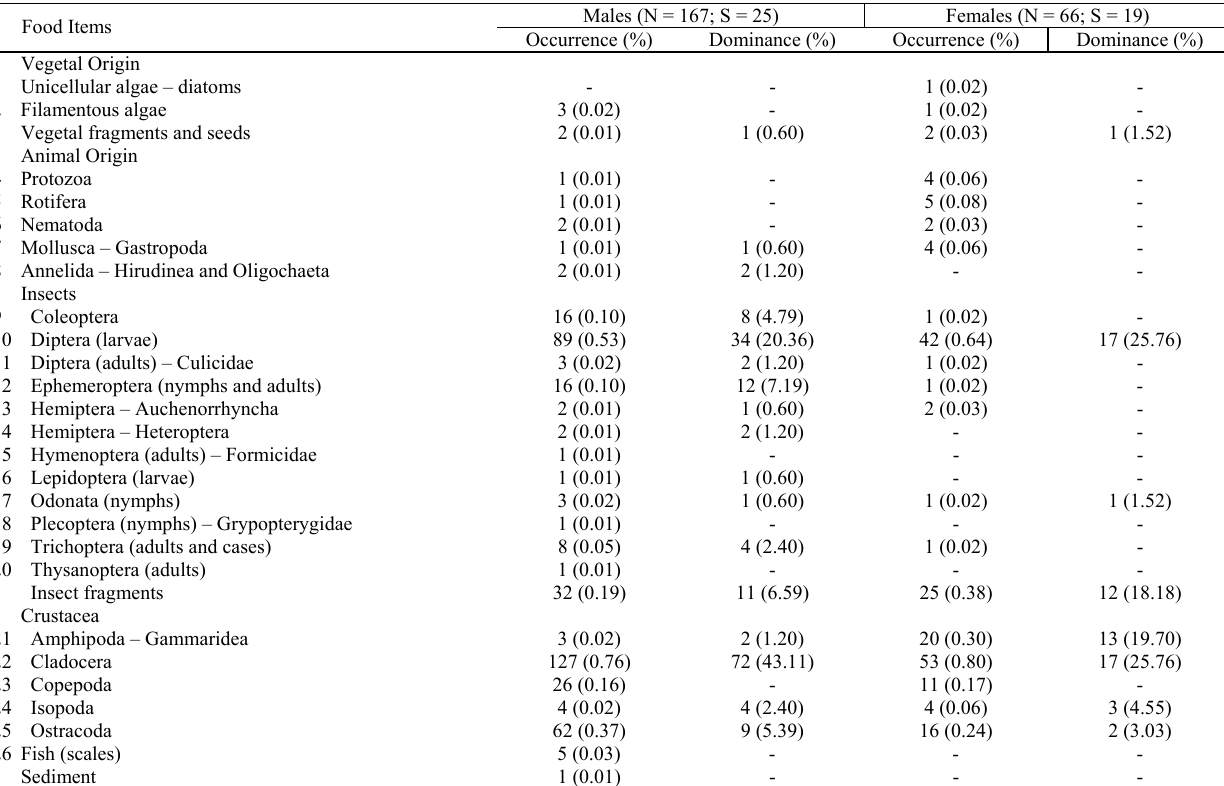
Table 1. Number of analyzed stomachs (N), richness of food items consumed (S), frequency of occurrence and dominance of each food item in the stomachs of males and females of Cynopoecilus melanotaenia from wetlands between São Gonçalo channel and Pelotas stream, during May and June 2005, and September